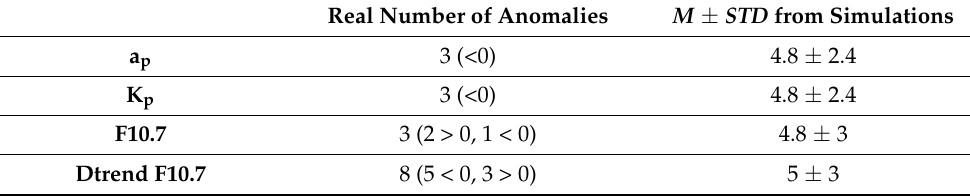
Figure 11. The number of detected anomalous anomalies for indices of ( a ) a p , ( b ) K p , ( c ) F10.7, and ( d ) dtrend F10.7 after making 100 simulated earthquake datasets. Please note the x -axis here is the number of the simulation. “ M ” and “ STD ” are Mean and Standard Deviation parameters, respectively. Mean and higher and lower bounds are drawn as green and red horizontal lines, respectively. The allowed ranges are defined as M ±STD , in which M and STD are the mean and the standard deviation parameters, respectively. Table 1. The real number of anomalies (central columns) found considering each index (left column) and the real earthquake catalog compared with the statistical mean value Ns ± one standard deviation, sd (right column) obtained from 100 simulations (the anomalies are also indicated as positive or negative). Please note that M is not an integer number because it is calculated as a mean of a series of numbers (so as the standard deviation STD ). The number of anomalies obtained from real data analyses is always comparable with the statistical mean value within one standard deviation, indicating its casual